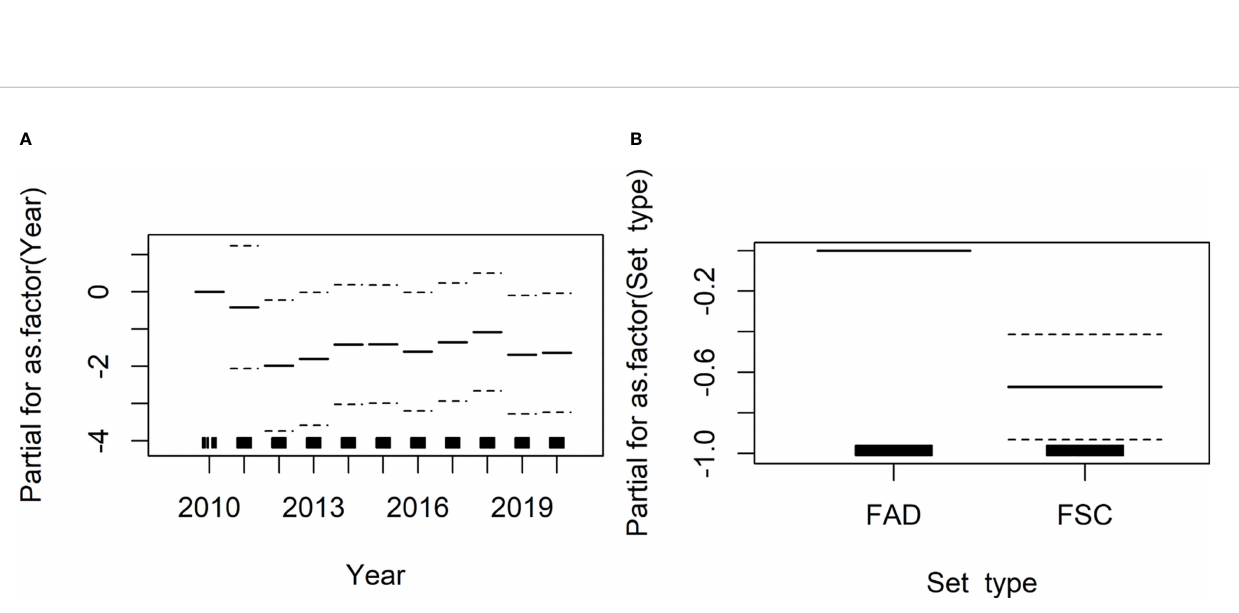
FIGURE 5 | Partial effects of two categorial predictor variables in the fi nal model for predicting the catch probability of an oceanic whitetip shark. (A) Year, and (B) Set type (FAD or FSC). The dashed lines indicate the 95% con fi dence interval for the parametric terms, and black boxes in the x-axis the distribution of the